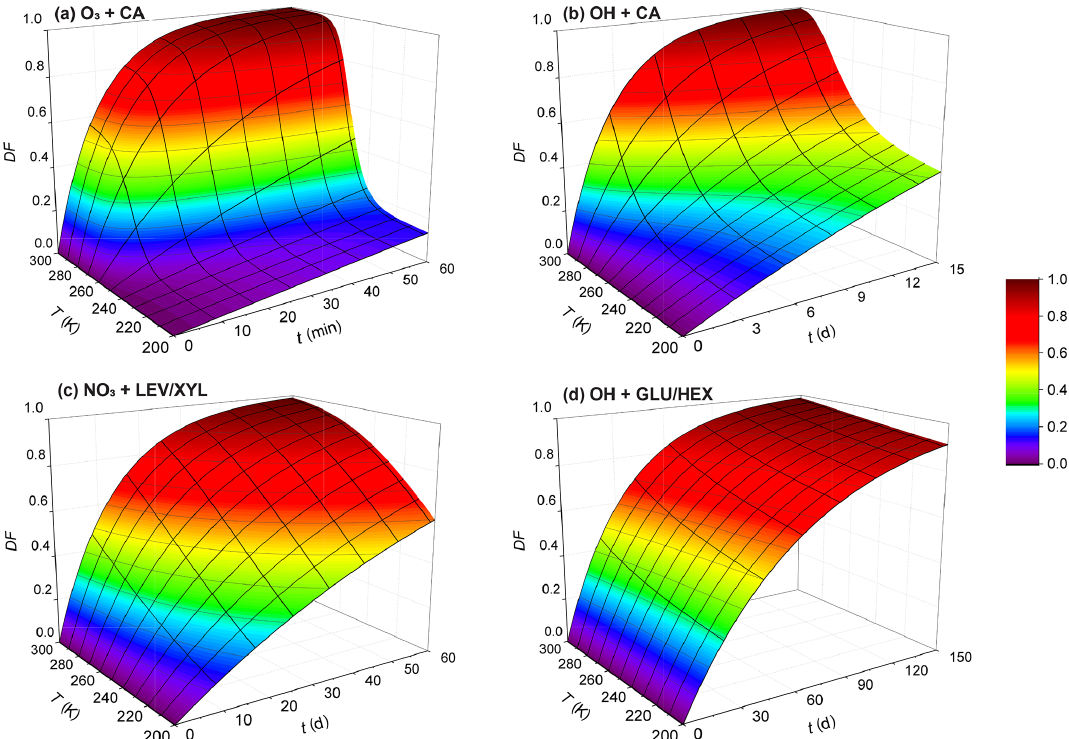
Figure 11. Exposure- and temperature-dependent particle degraded fraction (DF) for particles 200nm in diameter for (a) O 3 oxidation of canola oil, (b) OH oxidation of canola oil, (c) NO 3 oxidation of the LEV/XYL mixture, and (d) OH oxidation of the GLU/HEX mixture. Note the different scales on the time